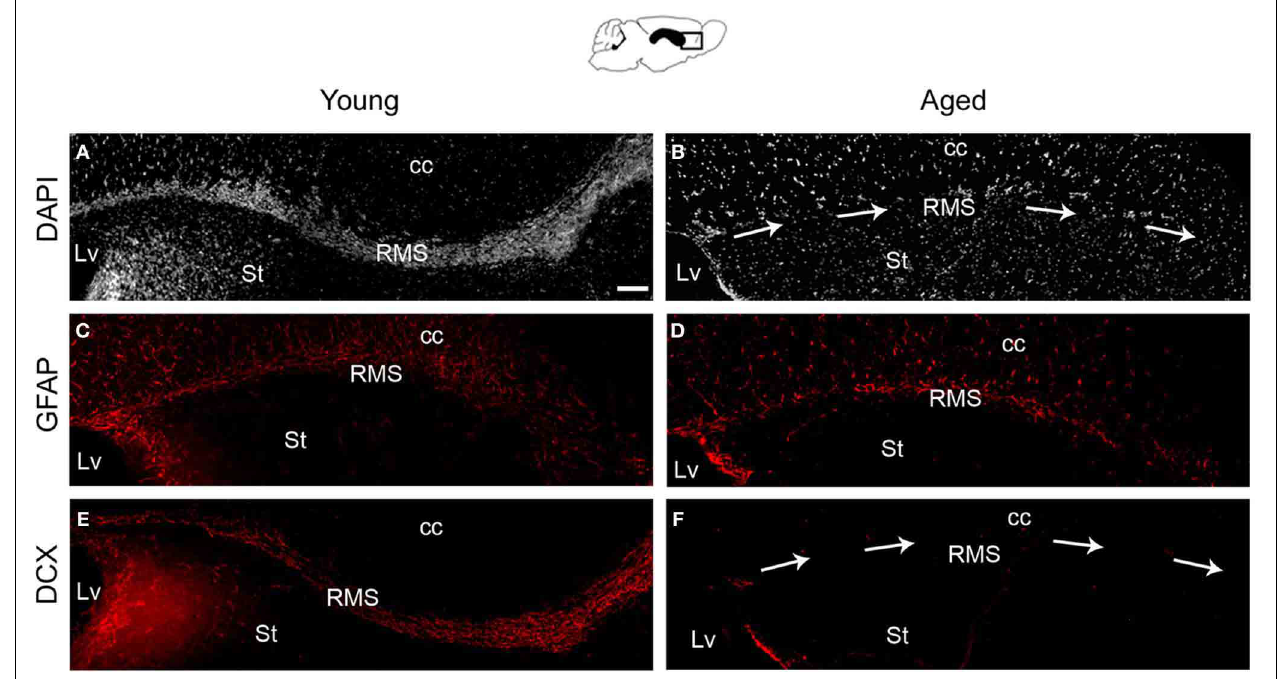
RMS immunolabeled with GFAP did not reveal remarkable differences in the population of GFAP + cells. (E) Young RMS immunolabeled with DCX. (F) Aged RMS (arrows) immunolabeled with DCX, showing a notable reduction of neuroblasts. cc, corpus callosum; St, striatum; Lv, lateral ventricle. Scale bar: 100 µ